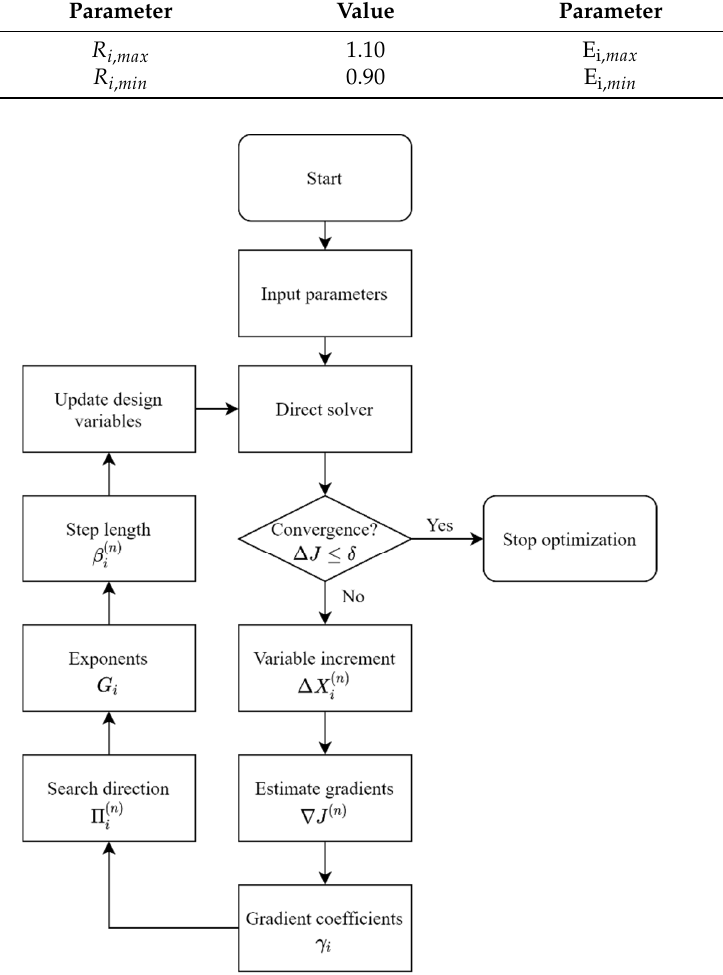
Figure 1. Flowchart of the VSCGM.